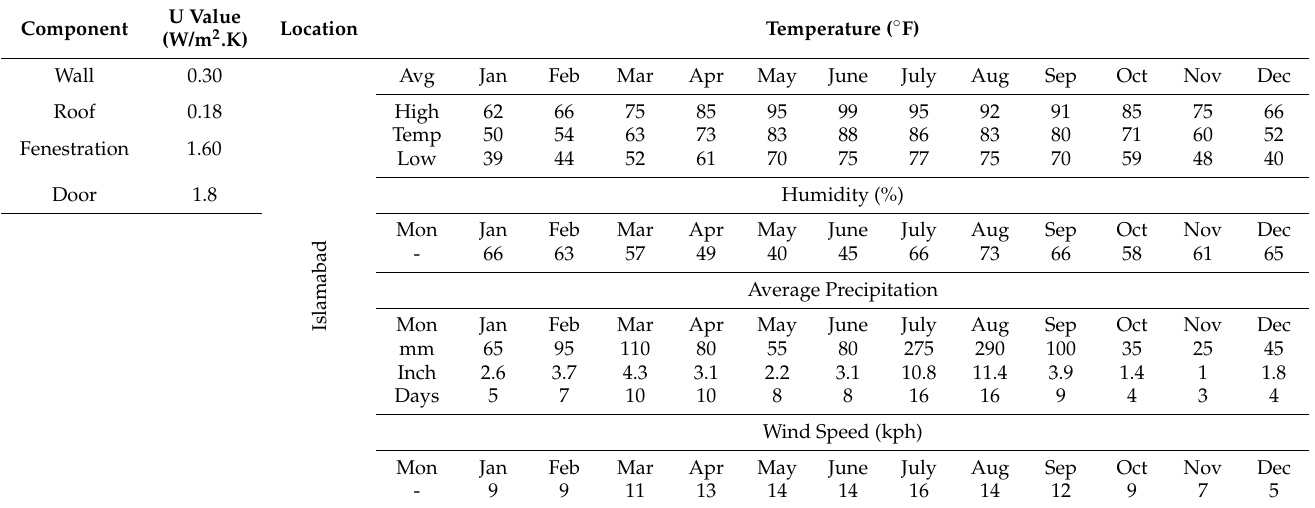
Table 2. Clean room construction details and the climate conditions of